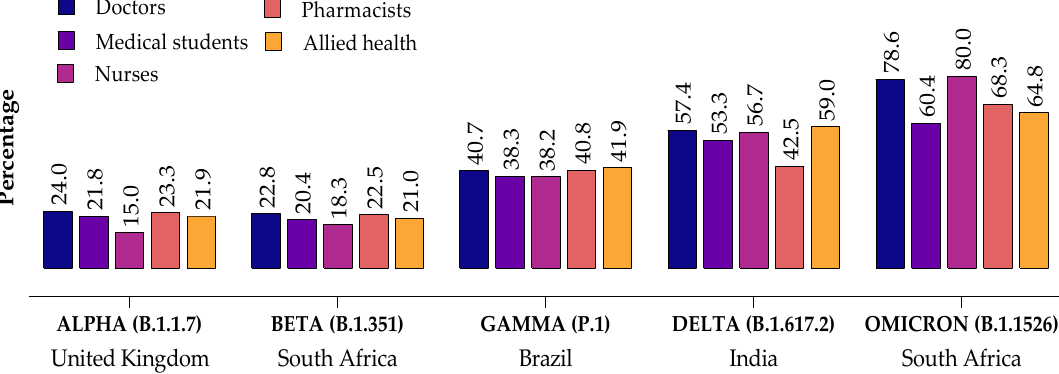
Figure 2. Healthcare workers correctly identified WHO-designated SARS-CoV-2 Variants of Concern (VOCs) and their countries of origin.